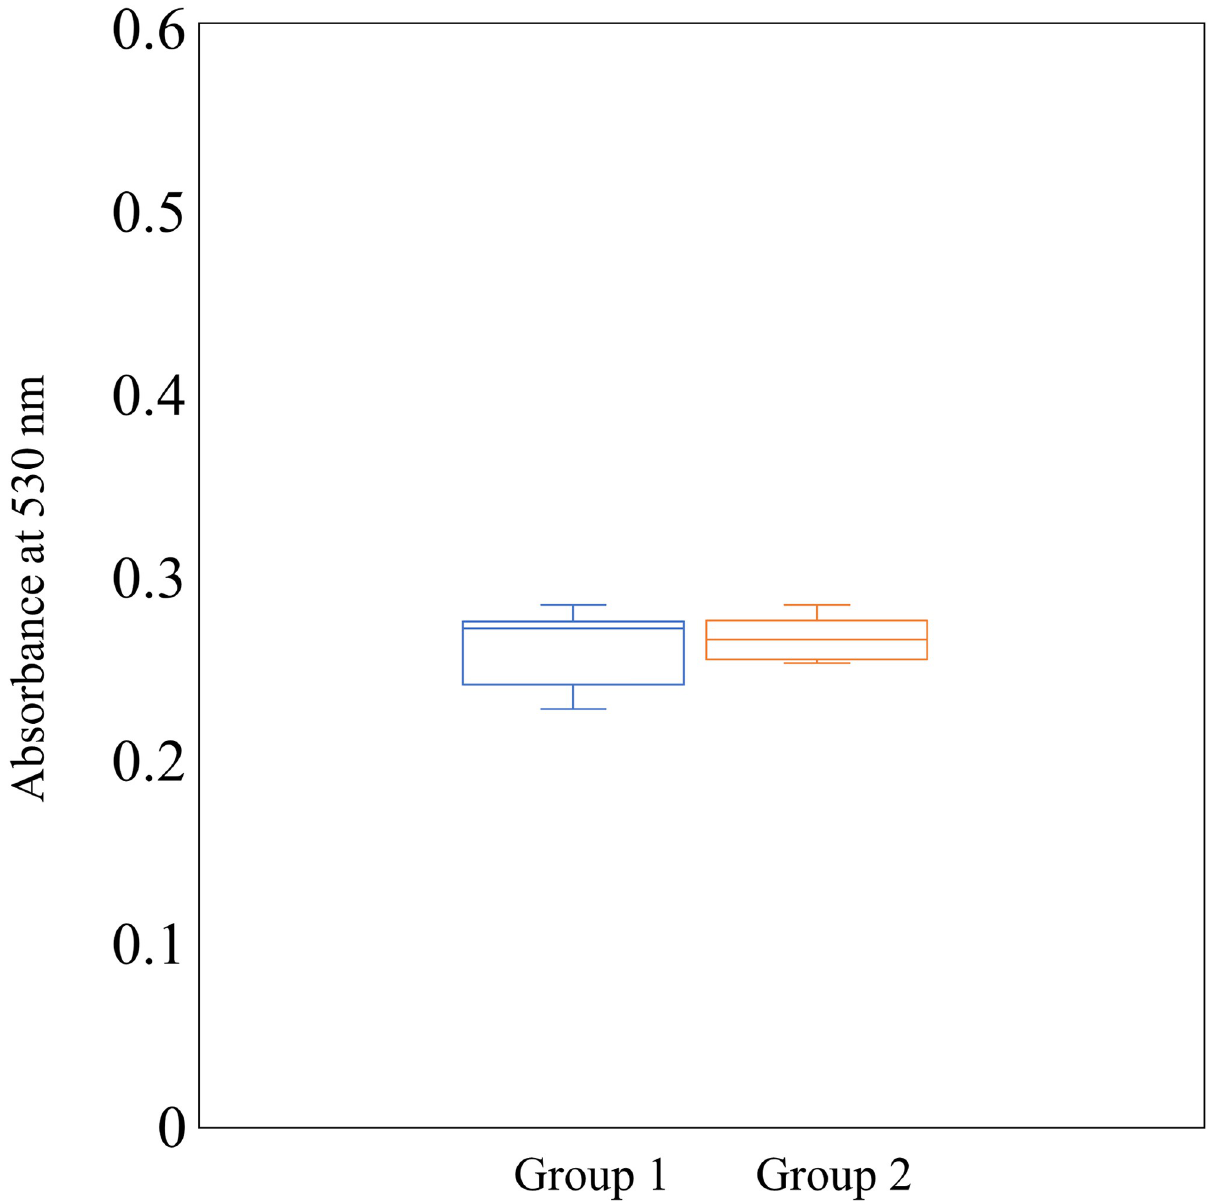
Fig 6. Cytochrome c binding assay with C . difficile strains. A cytochrome c binding assay with C . difficile strains was performed. Student’s t test was used to determine significant differences between the Group 1 and Group 2 C . difficile strains.